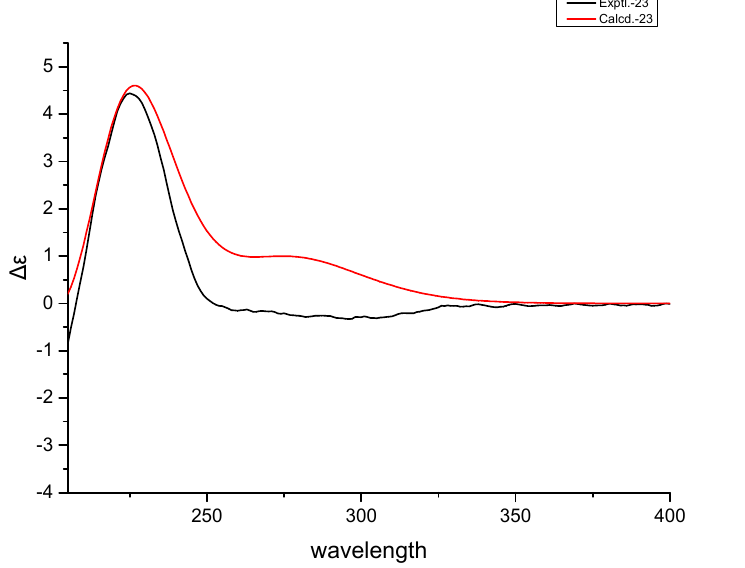
Figure 3. X-ray crystallographic structure of 1 .